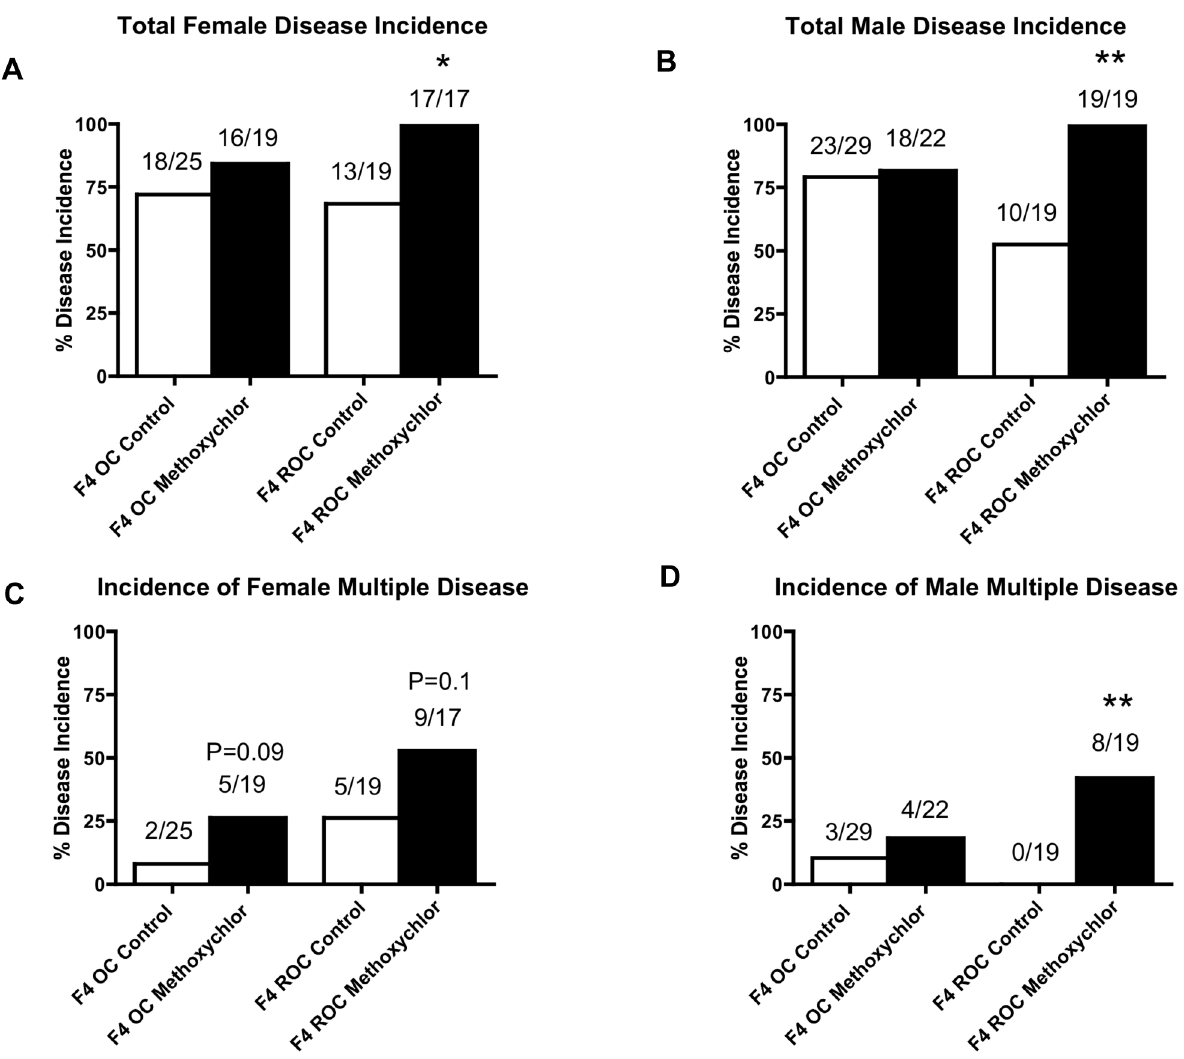
Figure 6. Ancestral exposure to methoxychlor promoted adult-onset transgenerational diseases in F4 generation reverse outcross offspring increasing total female disease, total male disease and multiple male disease incidences. Incidences of total disease in females (panel A), in males (panel B), multiple female disease (panel C), and multiple male disease (panel D) in the F4 generation outcross (OC) or reverse outcross (ROC) offspring of the control and methoxychlor lineages.